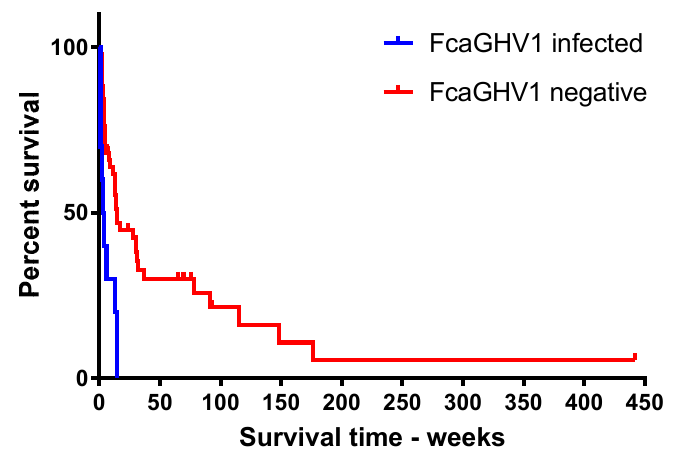
Figure 5. Kaplan-Meier survival analysis of lymphoma cases surviving longer than four days—FcaGHV1 DNAemic ( n = 10) vs. FcaGHV1 negative ( n = 51; p = 0.0019).